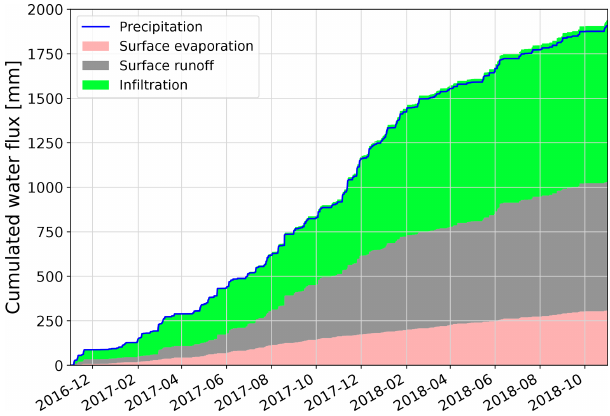
Figure 4. Filling and emptying of the surface storage over three separated wet–dry cycles in May 2018 at plot CP14 (FluSM step 2a).